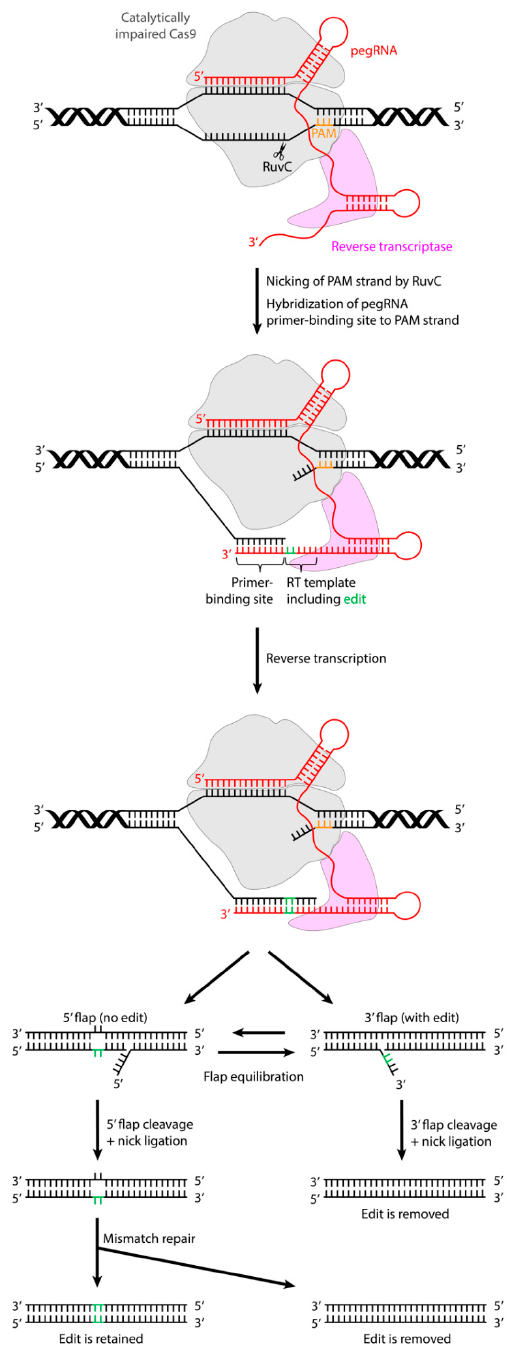
Figure 3. Mechanism of the action of the prime editing complex. Various prime editor systems have been developed by Anzalone et al., starting from PE1, in which Cas9 nickase is fused to a wild-type Moloney murine leukemia virus (M- MLV) RT [21]. To increase the editing efficiency, this RT domain was substituted with an engineered pentamutant M-MLV RT in PE2. Further advancements were made with